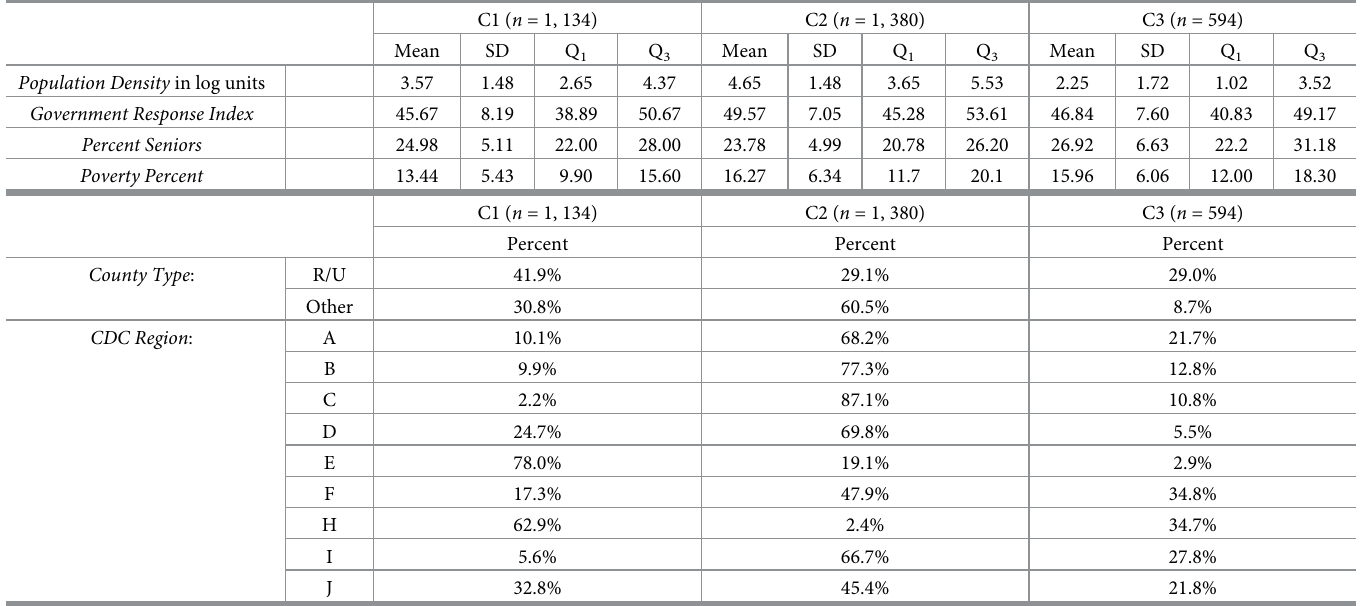
Table 1. A summary of how the predictor variables are distributed per cluster. For each numeric variable, we report the mean, standard deviation (SD), first quartile (Q 1 ), and third quartile (Q 3 ). For categorical variables, we report the distribution of each subcategory across the three clusters. The row summation for a subcategory may deviate slightly from 100% due to rounding errors.